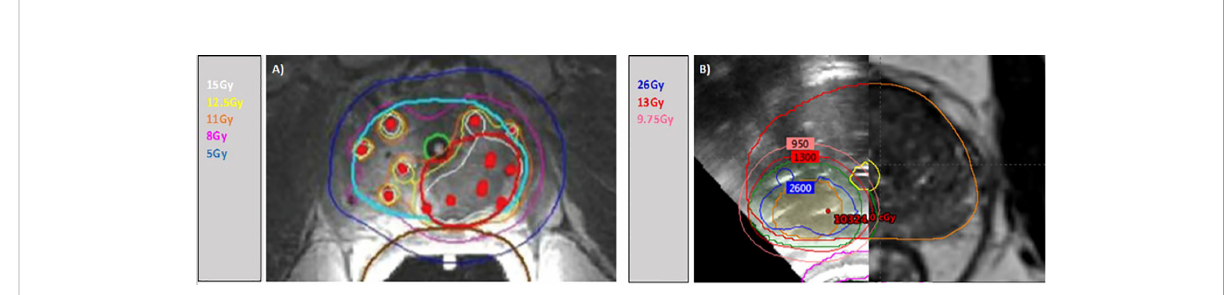
FIGURE 1 Isodose distributions for case examples. (A) ibBT with MRI-only guidance. Contoured in light blue the CTVwp, in red the PTV (GTV). Isodose lines: white 15Gy (135%), yellow 12.5Gy (114%), orange 11Gy (100%), pink 8Gy (75%) and dark blue 5Gy (50%). (B) fBT with TRUS/MRI guidance. Contoured in orange the GTV and green the PTV (GTV). Isodose lines: blue 26Gy (200%), red 13Gy (100%), pink 9.75Gy